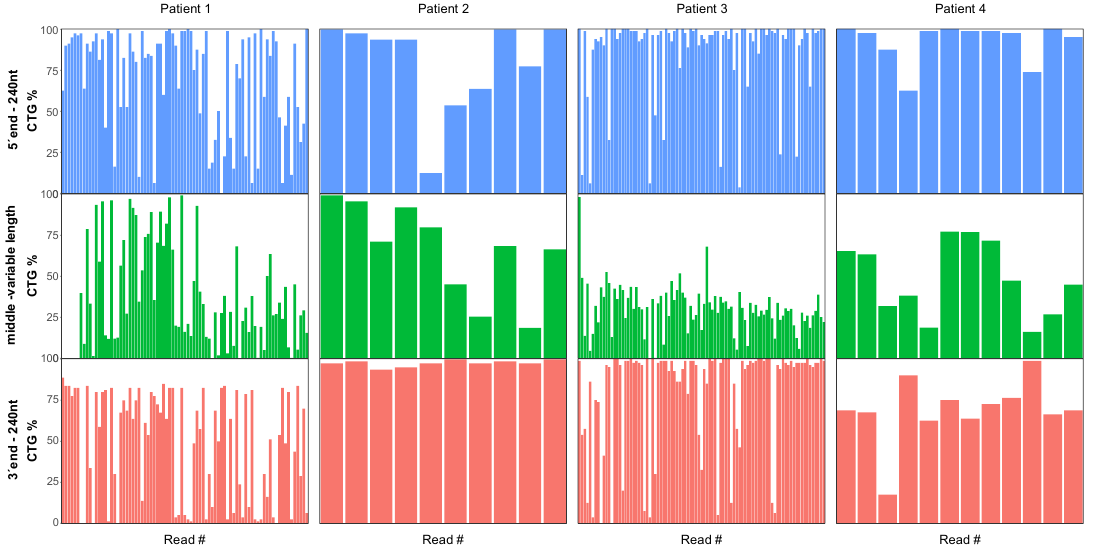
Figure 2. Fraction of CTG triplets per read in the expanded reads of each patient. Each read has been divided into three sections: 240 bp from the 5 ’ end (blue), the middle part of varying length (green), and 240 bp from the 3´end (red). The CTG fraction of the reads are lower in the middle part of the repeat, while both the 3′ and 5′ end in three patients (P2, P3 and P4) contains reads that consists entirely of CTG triplets. In patient 1, no reads in the 3′ end of the repeat consist entirely of CTG triplets, which might explain why the interruptions were only observed in the 3′ end of this patient using RP-PCR. The y-axis represents the percentage of CTG trinucleotides in each section of the read sequence, while the x-axis represents the individual reads divided into the 5′ end, the mid-section and the 3′ end.